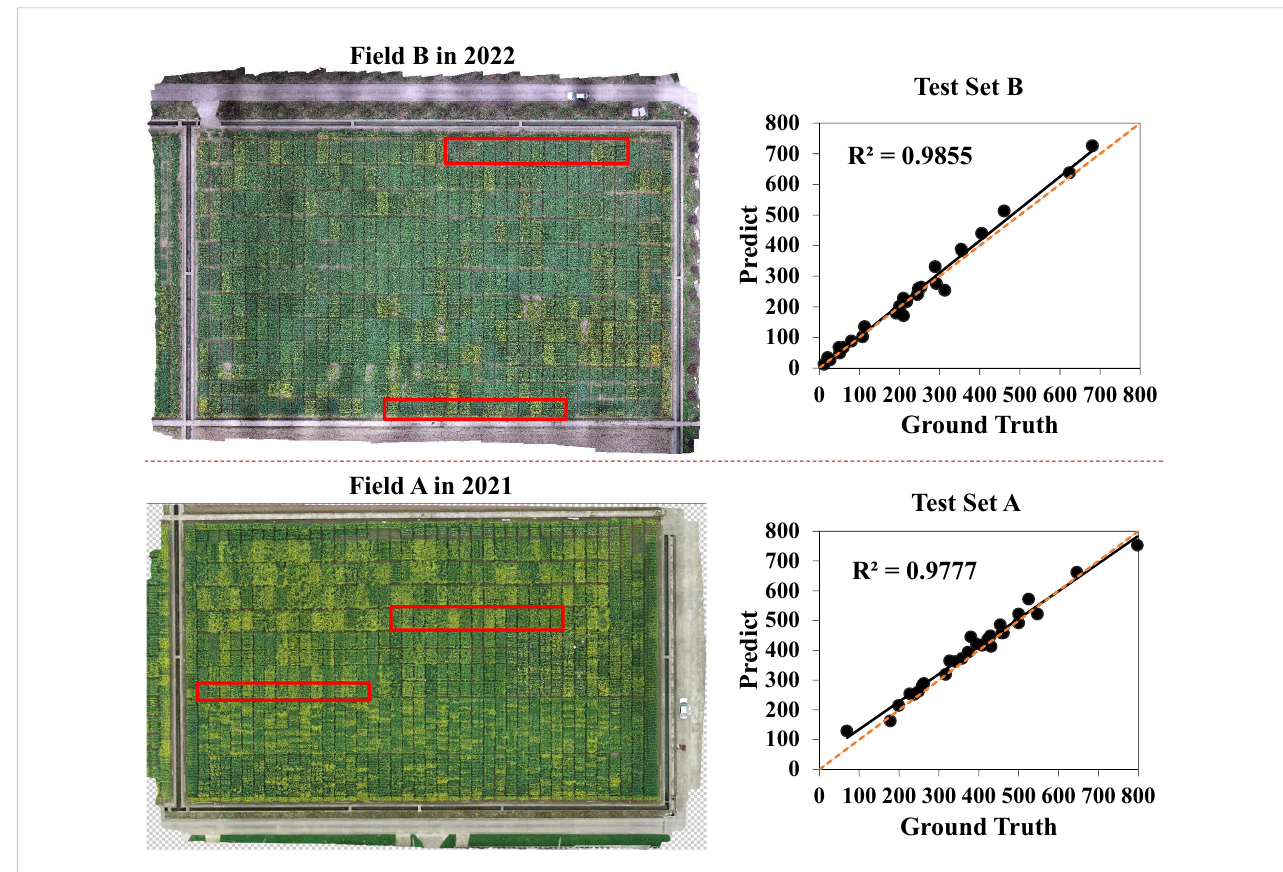
FIGURE 8 Comparison between inferred counts and manual counts on two novel test sets. Test set B from fi eld B in 2022 is represented by the red box area in the fi gure ’ s upper left corner, whereas test set A from fi eld A in 2021 is represented by the red box area in the fi gure ’ s lower left corner. The fi tting curves of test set B and test set A between the predicted value and the ground truth obtained by the proposed approach in different fi elds and years are respectively shown on the right. The orange dotted line represents the 1: 1 fi tted